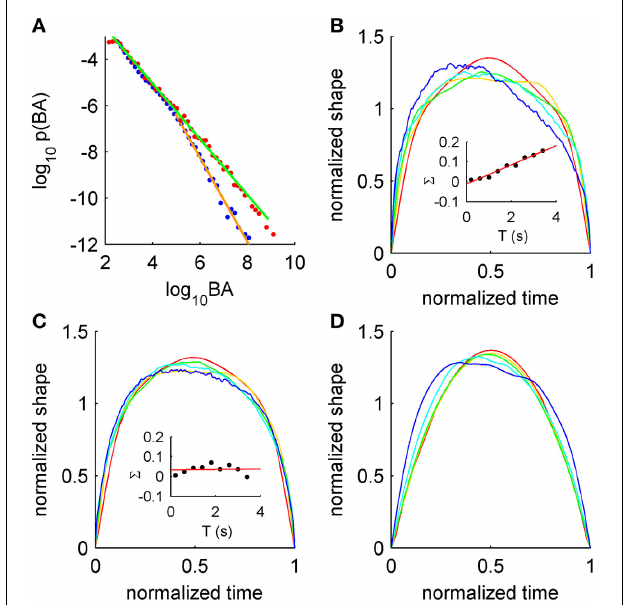
FIGURE 1 | Signatures of criticality in burst suppression EEG. (A) Distributions of burst area (BA) for burst suppression (red) and later in recovery (blue), with corresponding power-law fits (green and orange, respectively). (B) Asymmetric average burst shapes for burst suppression EEG over a range of durations (red to blue, shortest to longest). Inset: burst skewness ( (cid:2) ) as a function of duration T for burst suppression with linear fit (red). (C) Symmetric average burst shapes from EEG recorded later during recovery. Inset: burst skewness later in recovery. (D) Asymmetric average burst shapes from the simple model showing resource depletion. For more details see Roberts et al.